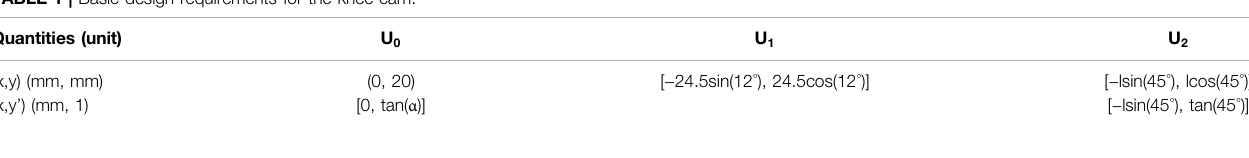
TABLE 1 | Basic design requirements for the knee cam. Quantities